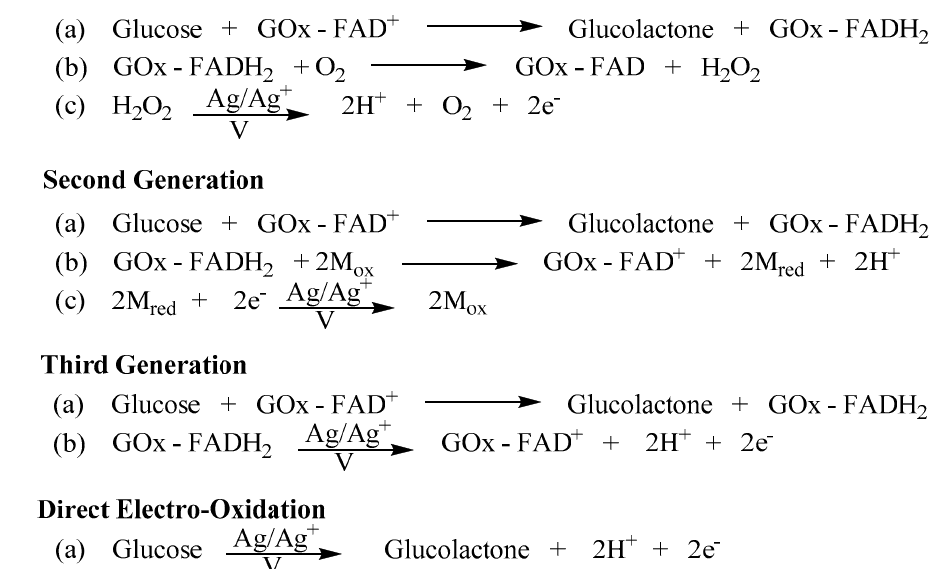
Figure 2. The steps involved in all generations of glucose monitoring via amperometric biosensors. The second- and third-generation of the electrochemical detection of blood glucose both employ the same nanolayer of GO x -FAD + for the conversion of glucose to glucono- lactone with the production of GO x -FADH 2 . For second-generation devices, instead of employing the natural co-substrate of molecular oxygen for the production of H 2 O 2 , these employ an impregnated artificial metal mediator [33–36]. Thus, in the oxidation of GO x - FADH 2 back to GO x -FAD +, the metal mediator is reduced. It is this reduced metal that when oxidized back by the silver working electrode yields a quantifiable amperometric signal [33–36]. With third-generation electrochemical glucose detectors, the metal media- tor has been completely removed. In this case, the nanolayer has been covalently or elec- trochemically bound to the silver working electrode [37,38]. Thus, the conversion of GO x - FADH 2 back to GO x -FAD + can be accomplished by direct electron transfer. Unlike the prior two generation devices, this approach measures reduction as opposed to the oxida- tion potential. Various other enzymatic approaches have also been evaluated that have